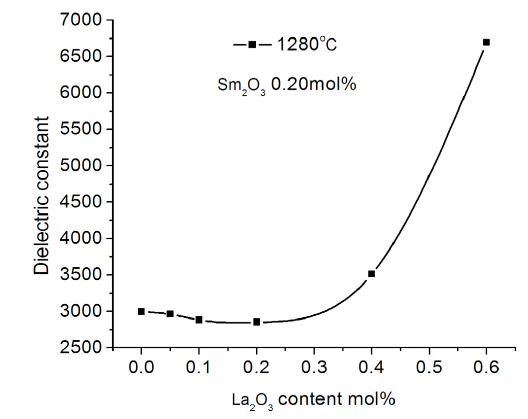
Fig. 3 The relationship curves between the dielectric constant and the content of La O 2 3